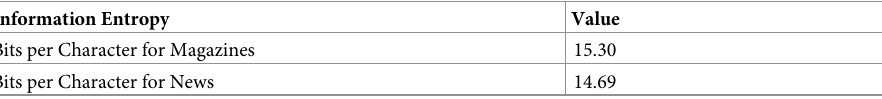
Table 5. Information entropy comparison between magazines and news text. Information